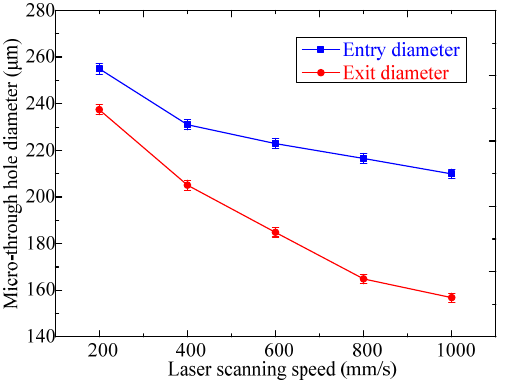
Figure 7. Effect of laser scanning speed on mean diameters of entry and exit through holes with the femtosecond laser pulse energy of 12 μ J.